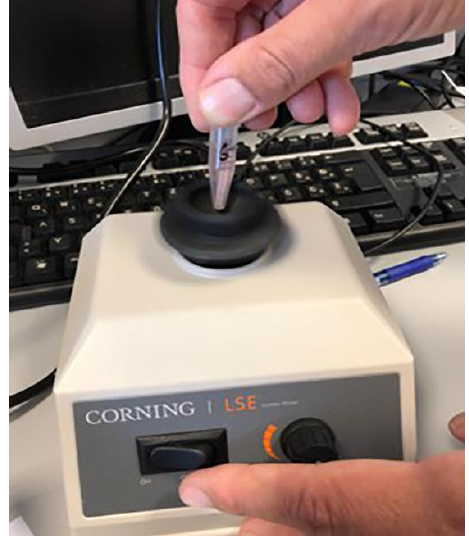
Figure 9. Vortexing .